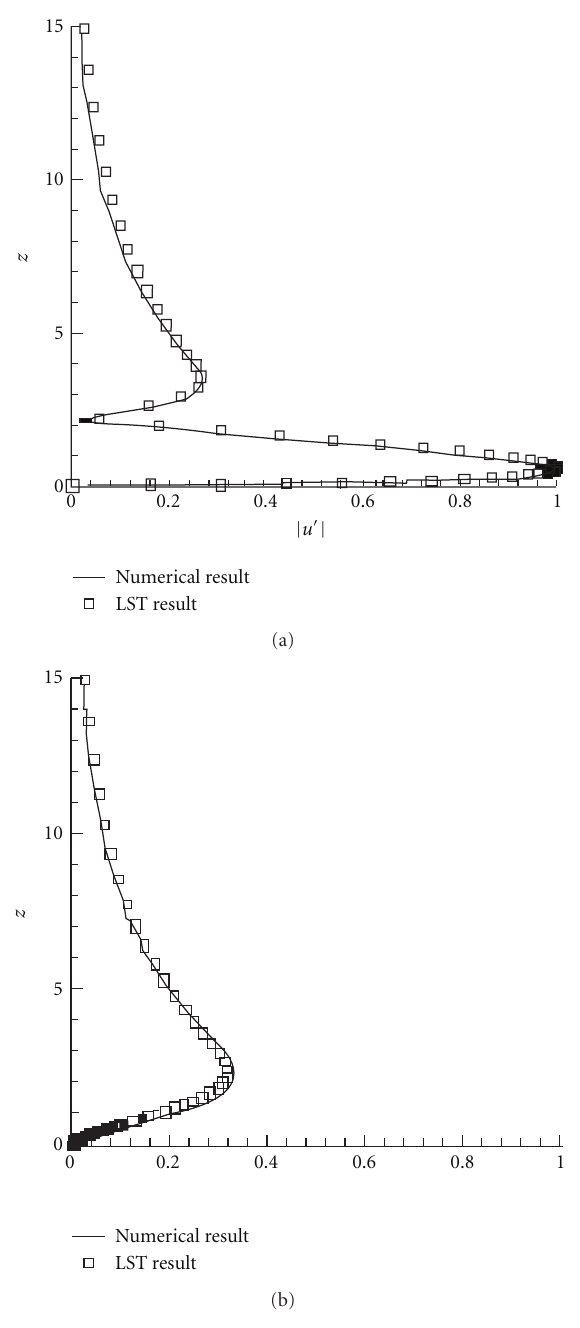
Figure 3: Comparison of the numerical and LST velocity profiles at Rex = 394300.